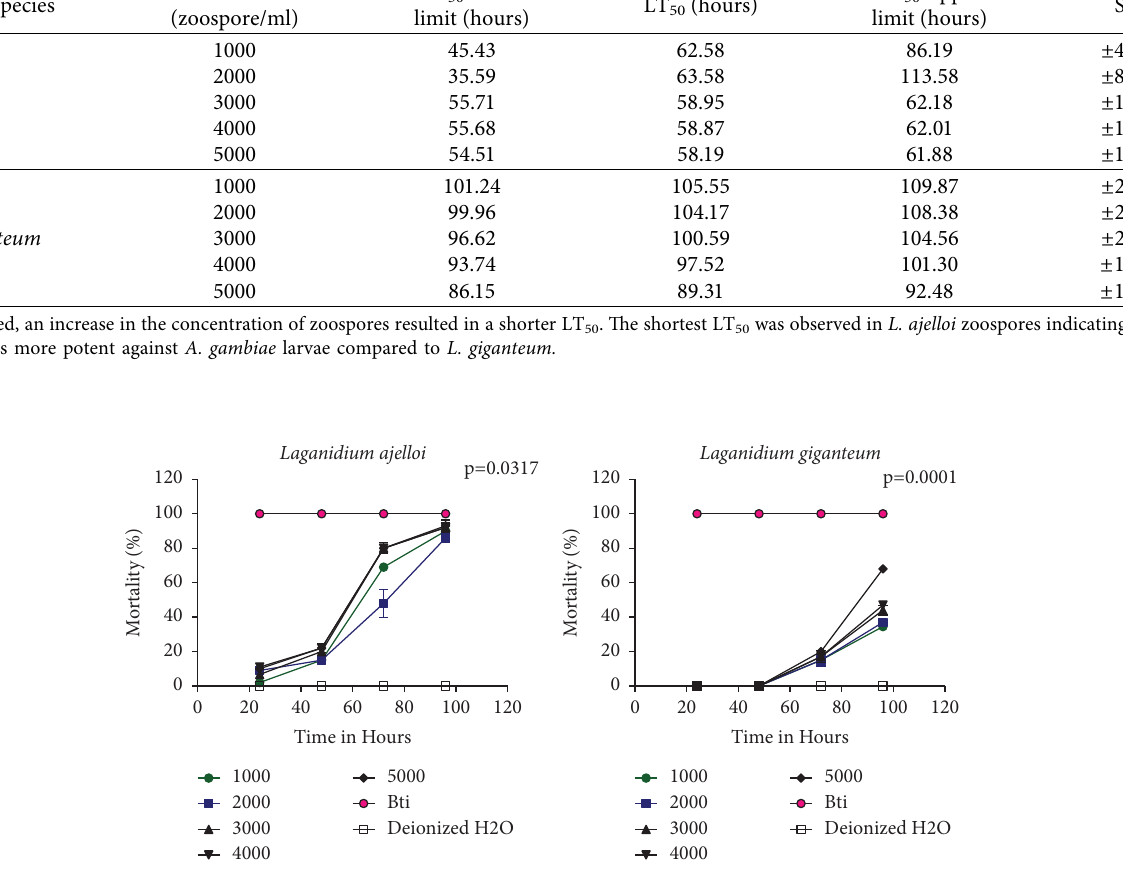
Table 2: Time taken by a specifc concentration of Lagenidium ajelloi and L. giganteum zoospores to kill 50% larvae (LT Fungal species